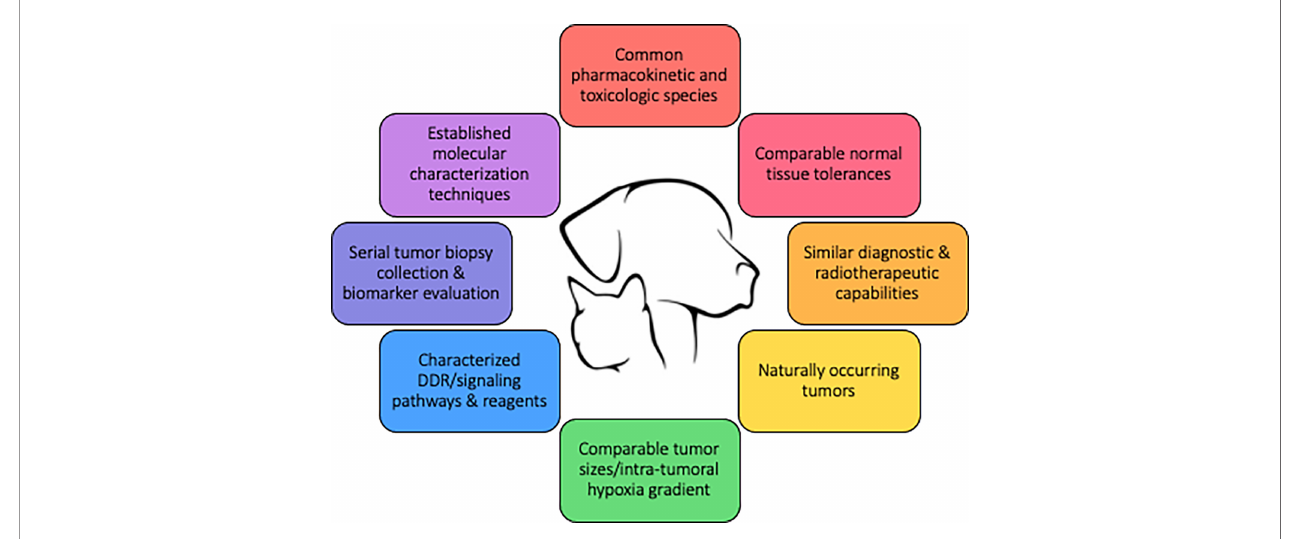
FIGURE 3 | Qualities of a large animal tumor model to improve the predictive value of drug-radiotherapy combination